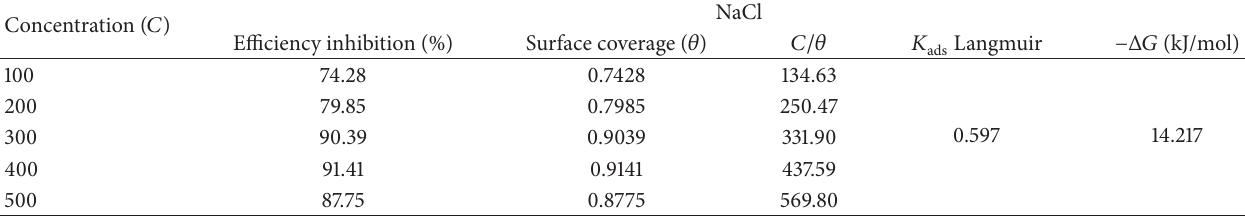
Table 5: Values of 𝐾 ads and Δ𝐺 ads when adding each concentration in Myrmecodia Pendans